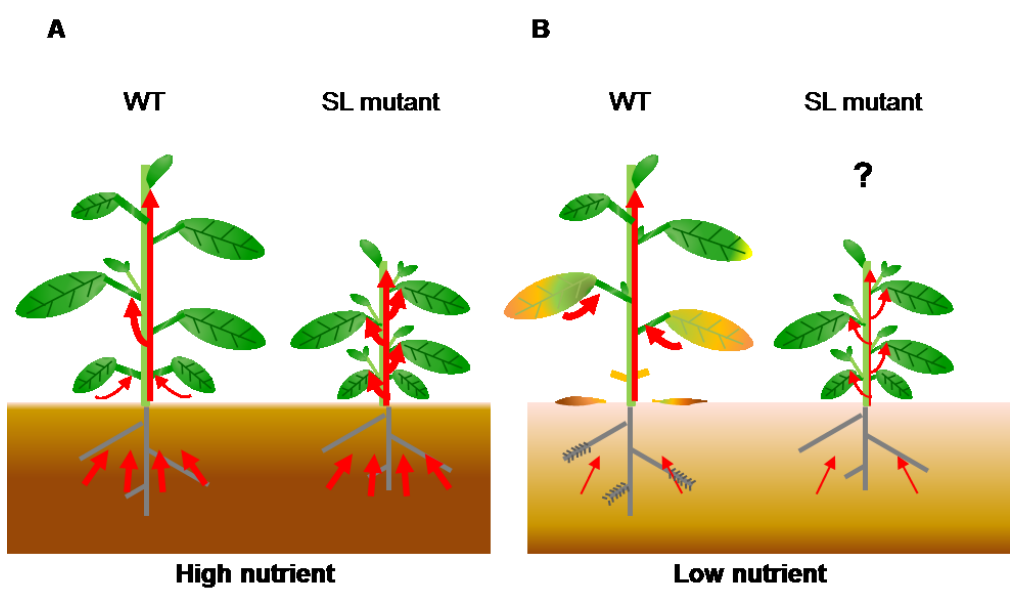
Figure 3. Transport of nutrients during leaf senescence under nutrient deficiency. ( A ) In nutrient-sufficient soil, plants absorb enough nutrients for growth and seed production. Wild-type plants show axillary bud outgrowth and the leaves remain green during leaf development because the SL levels are low. In SL mutants, the number of branches increases and nutrients absorbed from soil are evenly distributed between old and young organs because these plants have no SL signaling; ( B ) In nutrient-deficient soil, plants cannot absorb enough nutrients. In the wild type, increased SL levels inhibit shoot branching and accelerate leaf senescence to use limited nutrients. Nutrients are transported from old tissues to young tissues and seeds. SL mutants show enhanced shoot branching and delayed leaf senescence, which might reduce nutrient remobilization. Red arrows indicate flow of